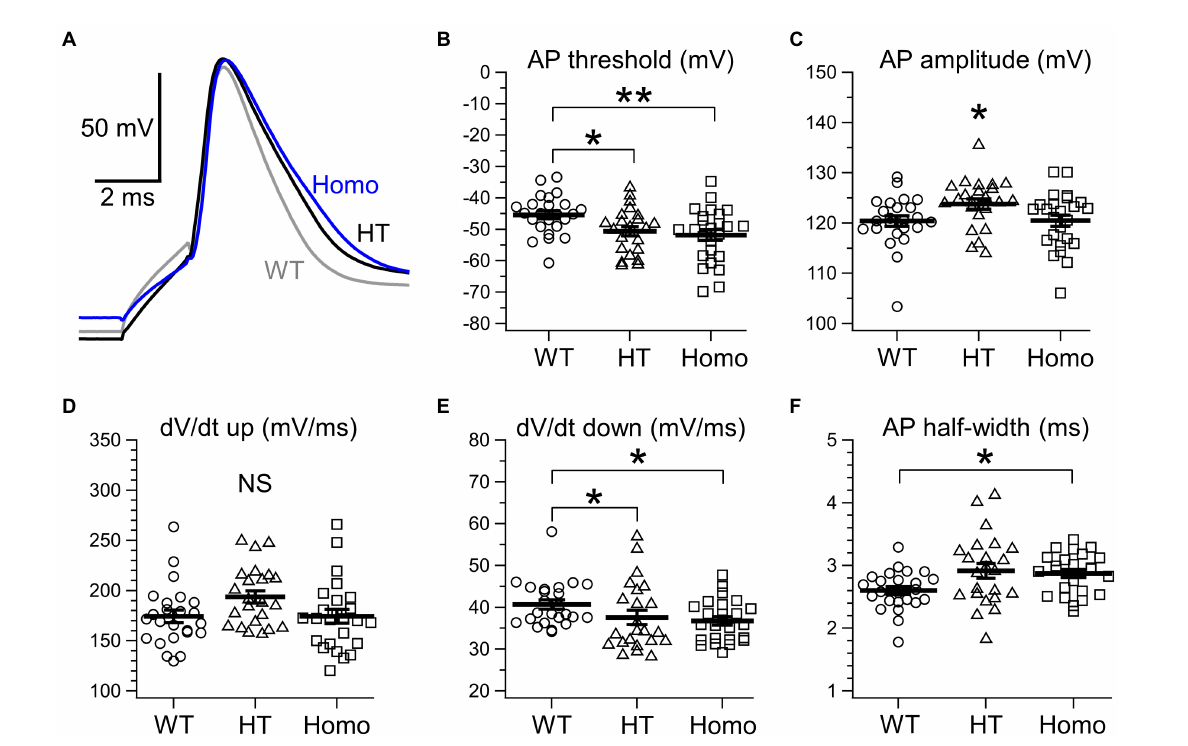
FIGURE 2 Properties of a single AP spike evoked by brief current injection. (A) Representative traces of a single AP evoked by a 2 ms current pulse. The gray trace obtained from a WT neuron, the black from a HT neuron and the blue from a Homo neuron are superimposed. (B) Threshold voltage level for an AP. * p < 0.05, ** p < 0.01 by REGW-F. See text for the values of mean ± SEM. (C) AP spike amplitude. * p < 0.05 by REGW-F. See text for the values of mean ± SEM. (D) The maximum dV/dt during spike upstroke (dV/dt up). WT: 174.4 ± 6.2 mV/ms, HT: 193.7 ± 6.1 mV/ms, Homo: 174.4 ± 6.9 mV/ms; p = 0.062 by ANOVA. (E) The maximum negative dV/dt during spike downstroke (dV/dt down). Plots indicate absolute values of the dV/dt. * p < 0.05 by K-W. See text for the values of mean ± SEM. (F) The width at half-maximal spike amplitude. * p < 0.05 by Dunnett’s T3. See text for the values of mean ± SEM. (B–F) Symbols indicate the values in individual neurons, and thick bars with error bars indicate means ±